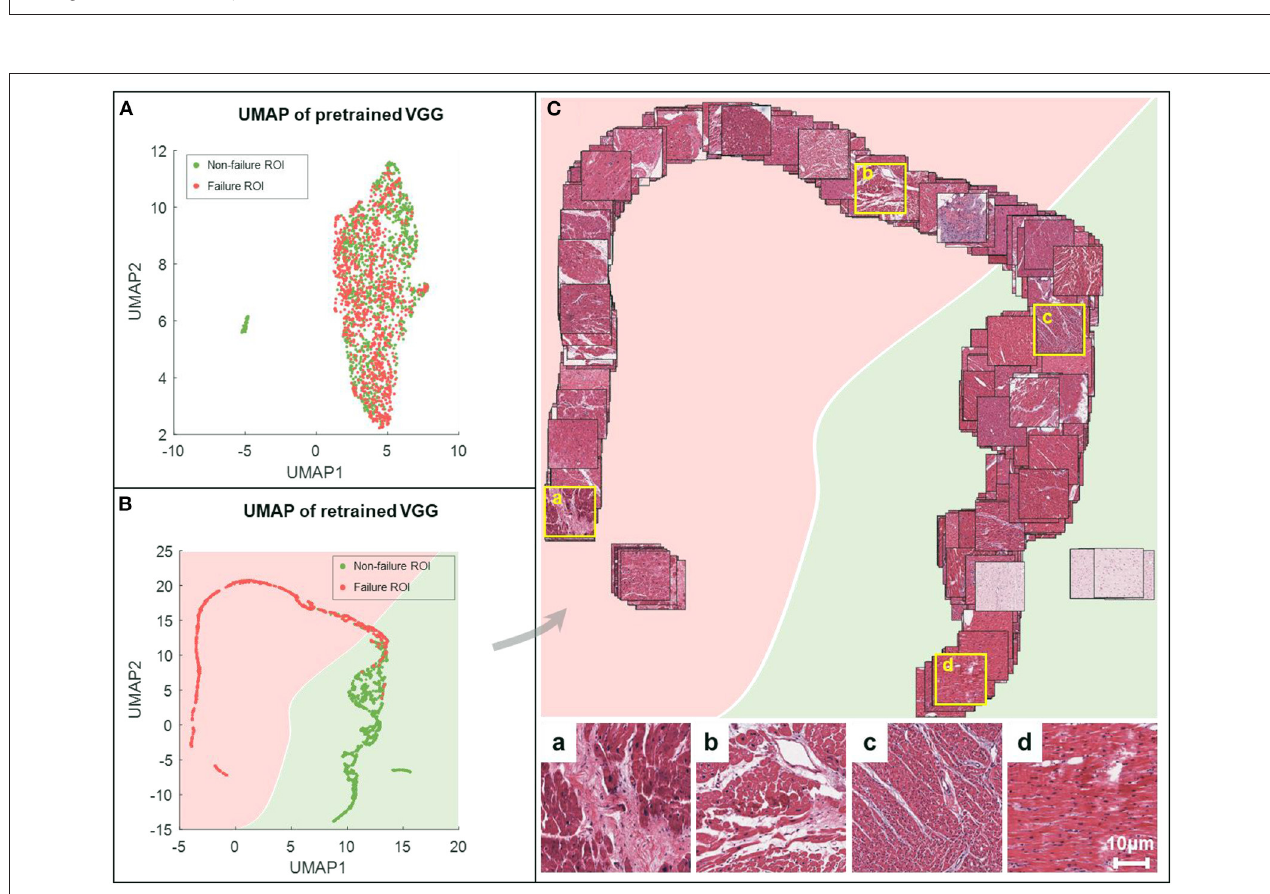
FIGURE 5 | UMAP embeddings of the deep features obtained from VGG-19 networks. All the images are processed by the feature extractor, resulting in features of length 512. These features are then reduced to 2-dimension (2-D) via UMAP (red for failure label, green for non-failure label) for the characterization of spatial relationships on the ROI-level. The 2-D UMAP embeddings are given for pretrained VGG (A) and retrained VGG models (B) . (C) Corresponding EMB images are projected onto the UMAP coordinates for the sake of visualization. For better visual effect, 20% of samples are randomly selected. Representative examples are shown in the bottom, where the first two (a,b) are failure samples, and the others (c,d) are non-failure samples.